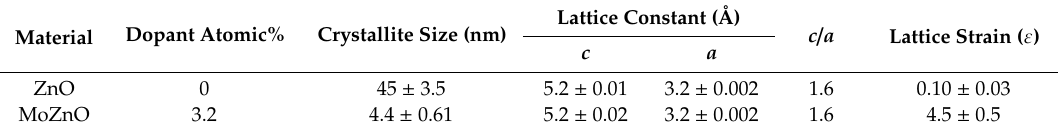
Table 2. Calculated crystallite size, lattice constants, and microstrain values of ZnO and MoZnO. Material